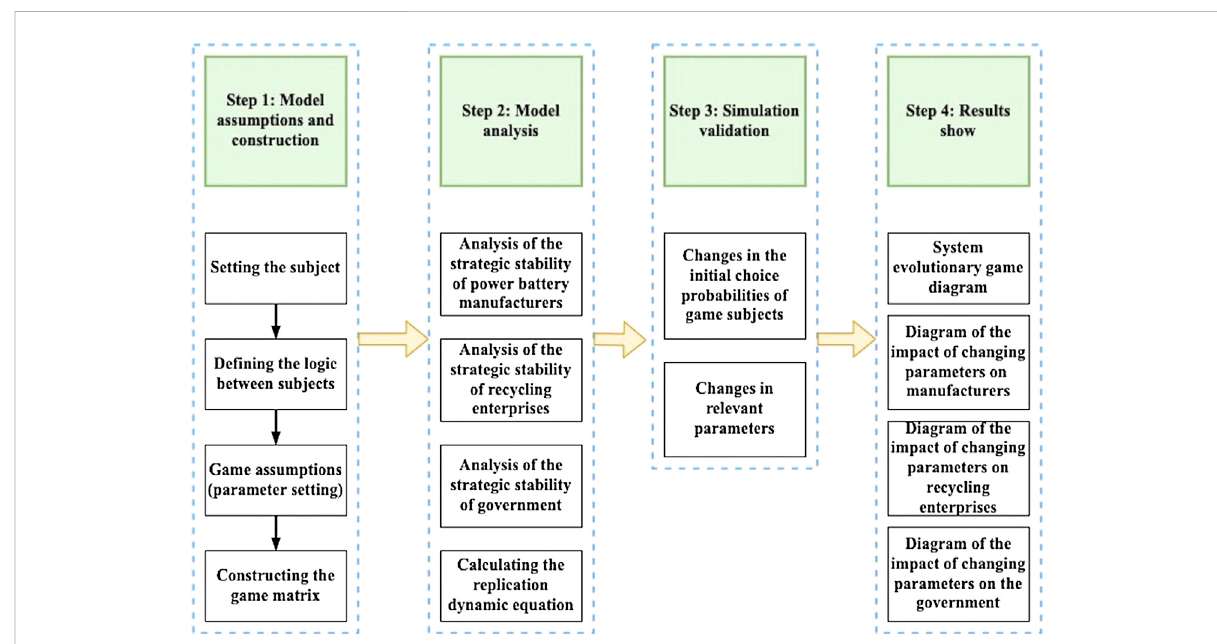
FIGURE 1 Framework for studying the evolution of a tripartite game for recycling critical metals in power